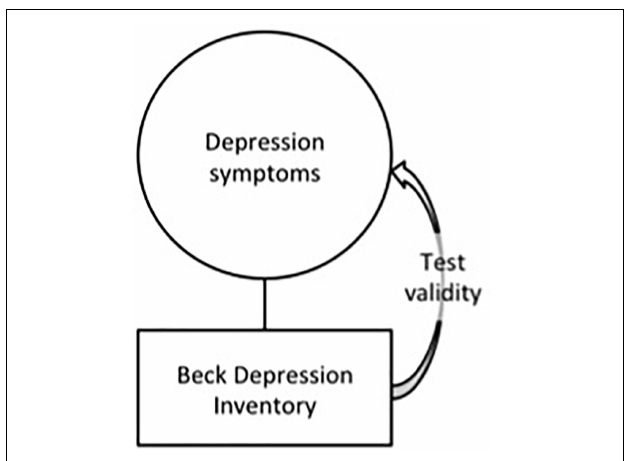
FIGURE 1 | The Beck Depression Inventory (BDI) graphically displayed as a valid operationalization of the construct depression